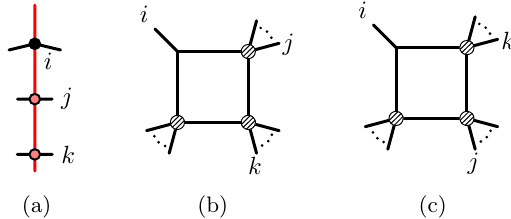
Figure 1. The twistor diagram shown in (a) depicts branch (16) of solutions to the three-mass box on-shell conditions hL i (cid:0) 1 i i = hL i i +1 i = hL j j +1 i = hL k k +1 i = 0, which is a valid